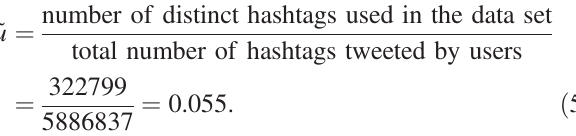
∼ Dk − γ as k 1 . 1 × 10 4 , fitted as min ¼